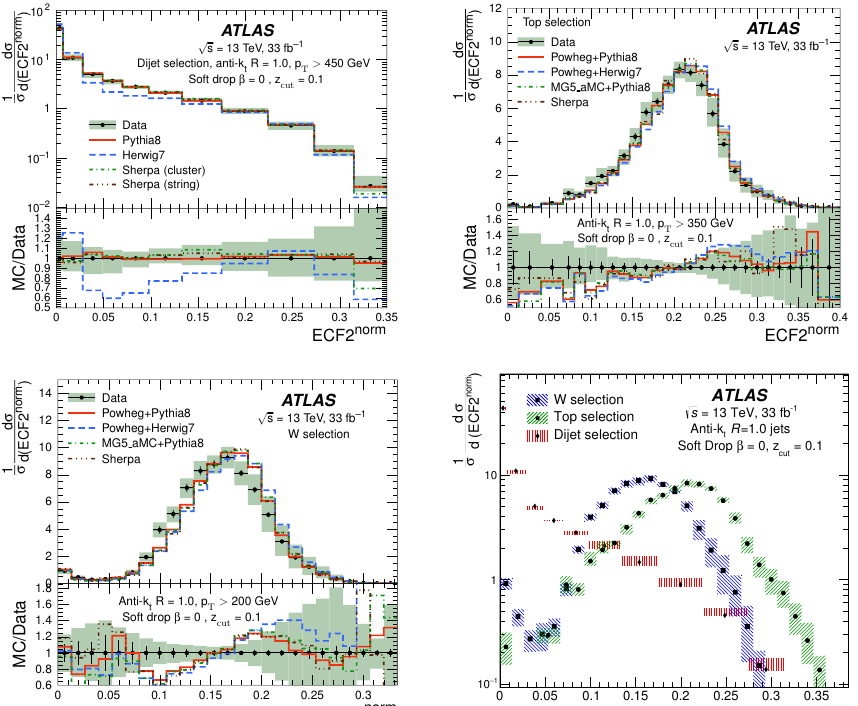
Figure 7 . The distributions of ECF 2 norm compared with different MC predictions for soft-dropped large-radius jets from dijet (top left), top (top right), and W (bottom left) selections. For the dijet selection, Sherpa is tested with two different hadronisation models. Data are compared between the soft-dropped large-radius jets for the three selections mentioned above (bottom right). The subscript norm indicates that normalised versions of ECF 2 norm are used. The shaded bands represent the total uncertainty, while the error bars show the statistical uncertainty, except in the bottom right plot, where the shaded areas represent the total